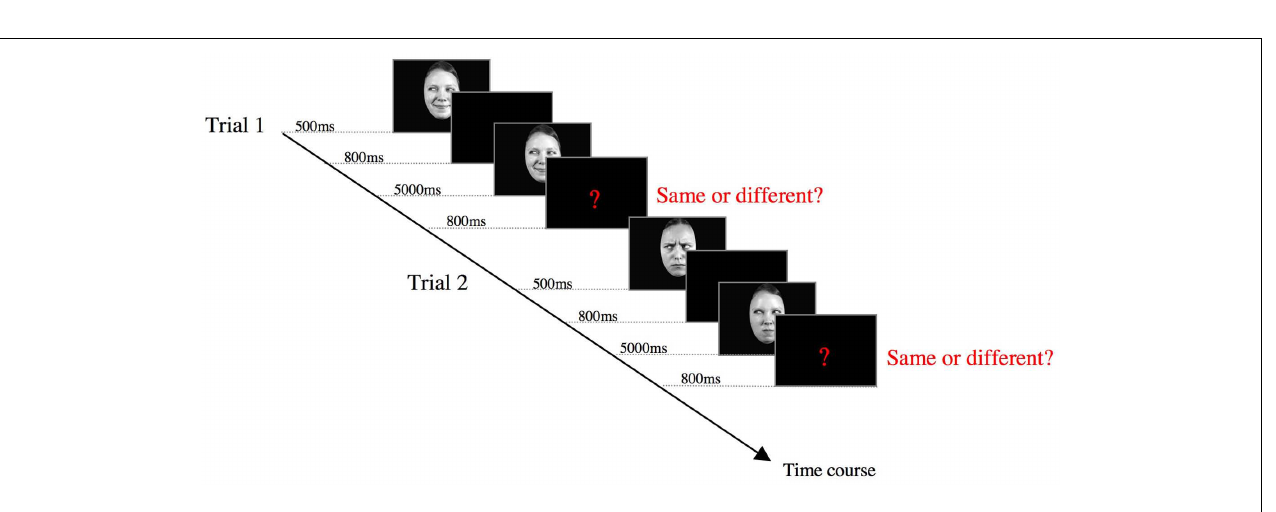
FIGURE 1 | Experimental time course for two trials in the same-different